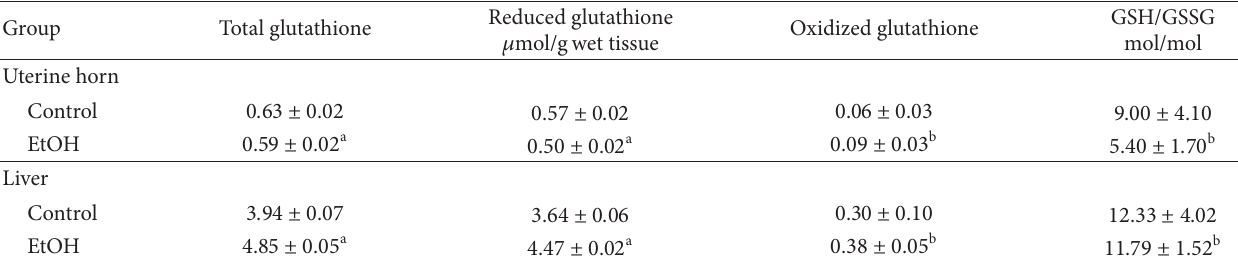
Table 5: Glutathione levels in uterine horn and liver tissue from rats receiving an ethanol containing liquid diet.